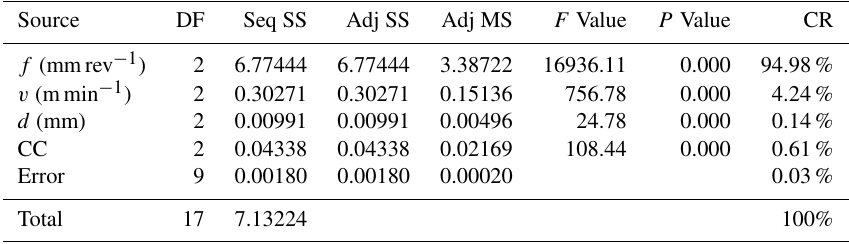
Table 8. ANOVA for Surface roughness Ra.